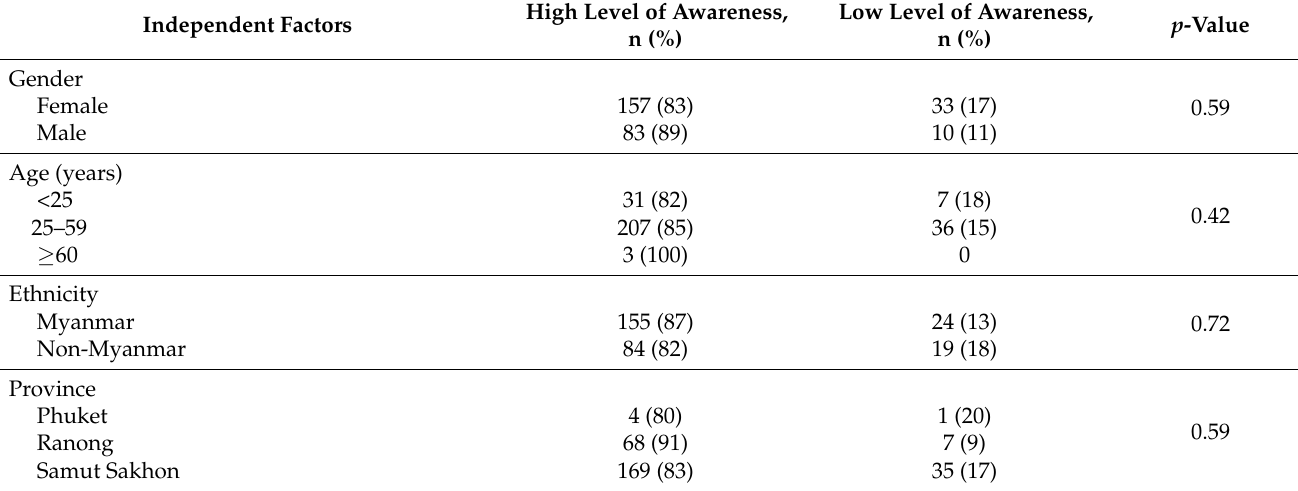
Table 3. Univariate analysis on awareness of public health measures on COVID-19. Independent